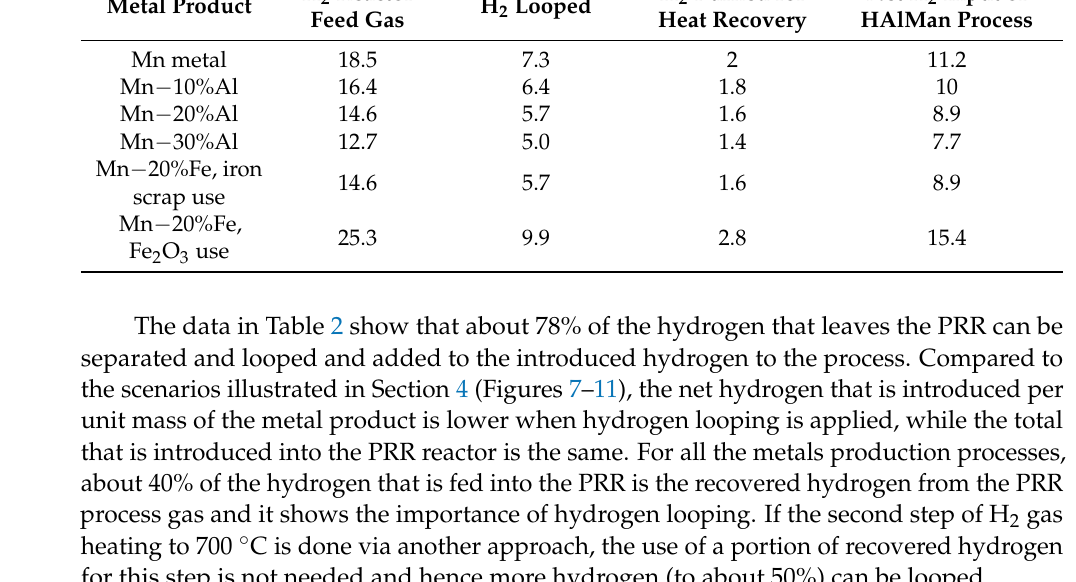
Table 2. The amount of H2 that is used, looped, or burned in the HalMan process (kmol/kg metal). Metal